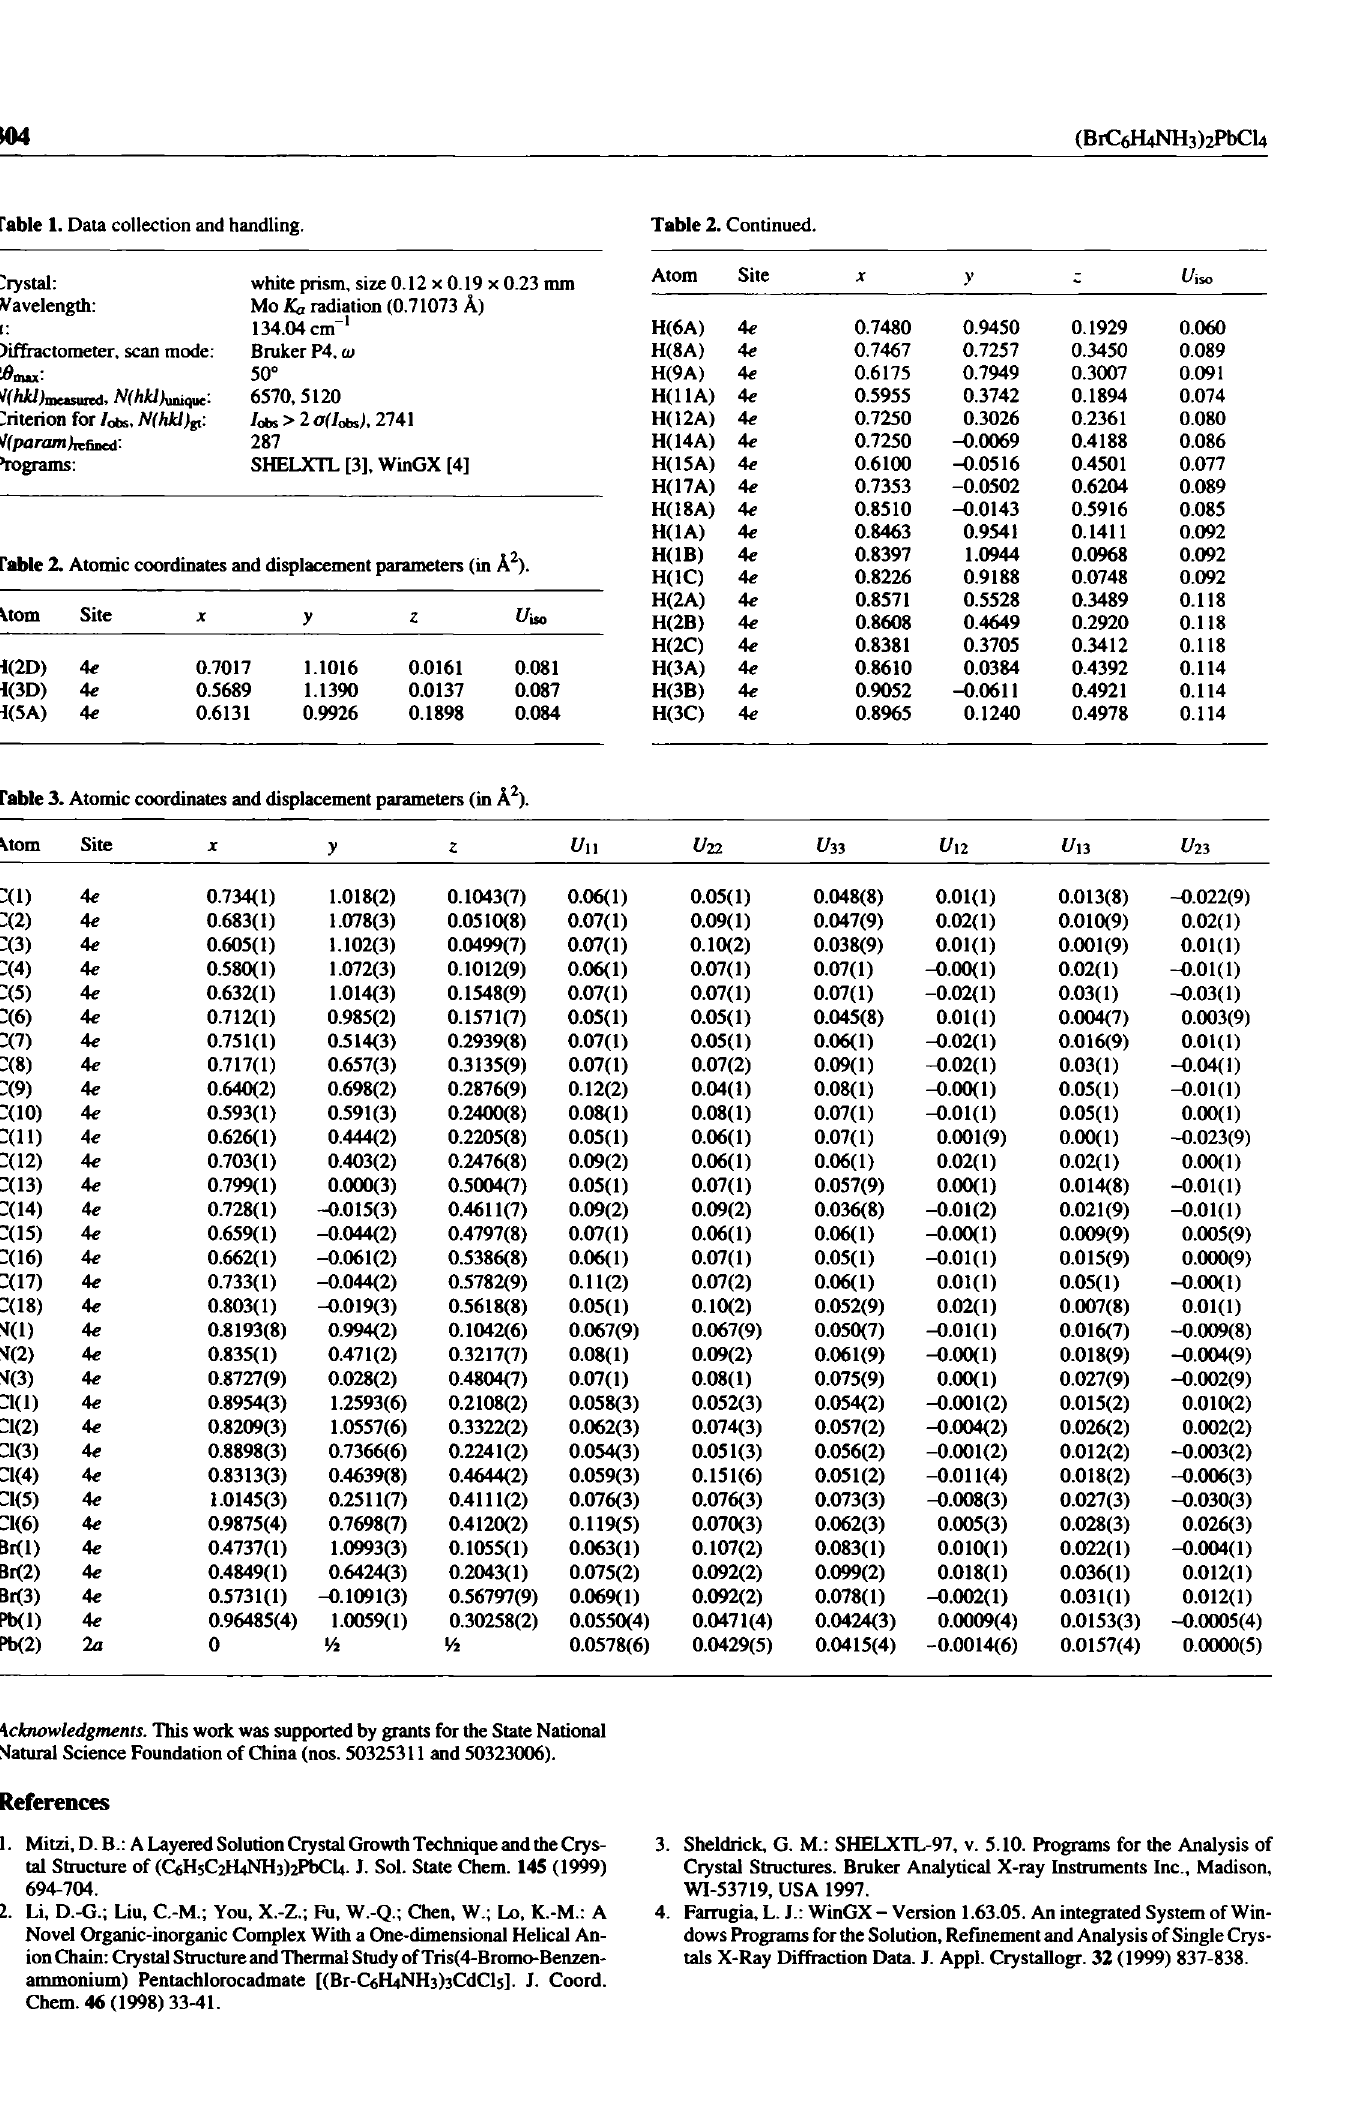
Table 2. Atomic coordinates and displacement parameters (in A 2 ).